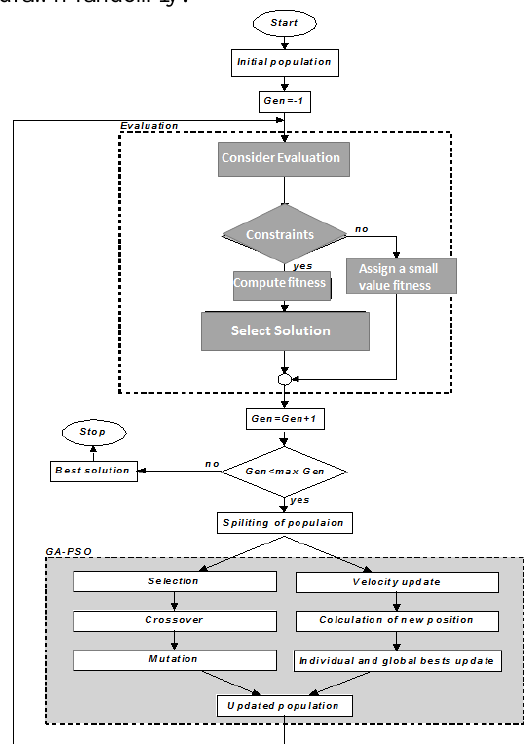
Figure 3. Flowchart of the GA-PSO